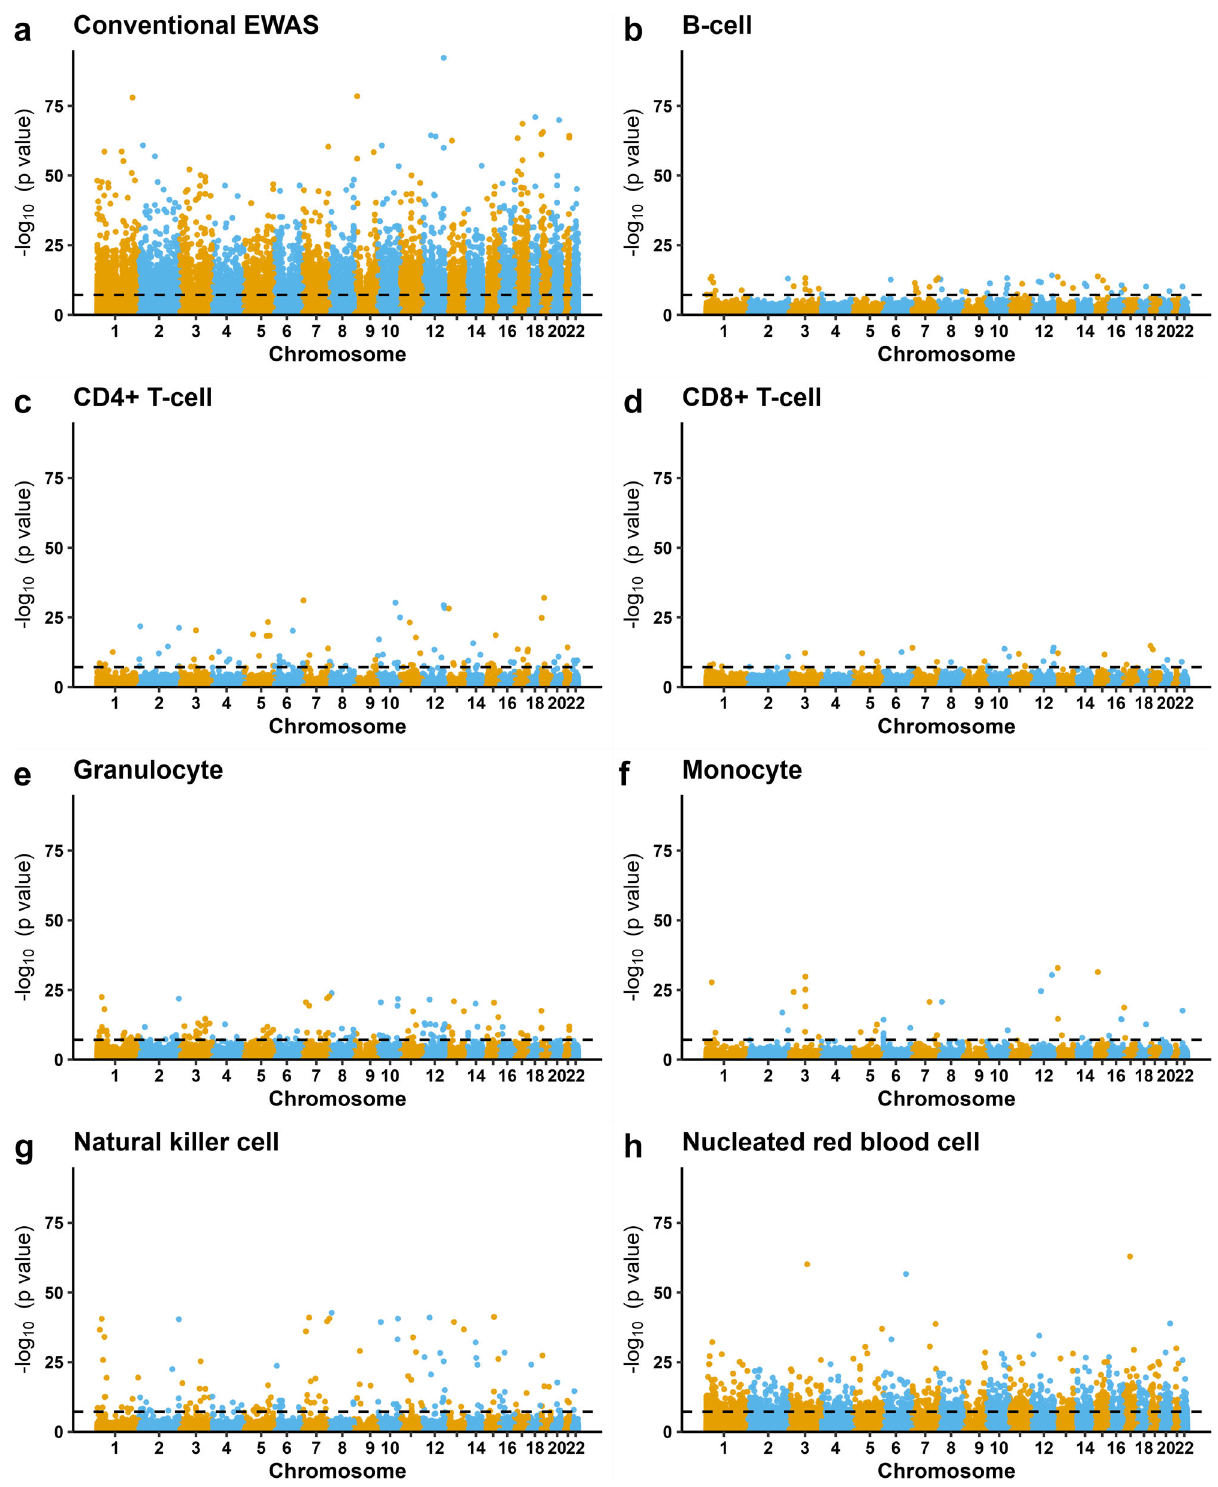
Fig. 2 Manhattan plots of the epigenome-wide DNAm associated with GA in START ( n = 953). a Results from the conventional EWAS where we adjusted for the estimated cell-type proportions (see Methods for details of the statistical model). b – h Results for each of the seven cell types from the cell- type speci fi c analysis using CellDMC. CpG loci are aligned on the x-axis according to their genomic coordinates. The y-axis represents the − log 10 p values. The dashed black line denotes the Bonferroni-corrected genome-wide signi fi cance threshold ( p B <